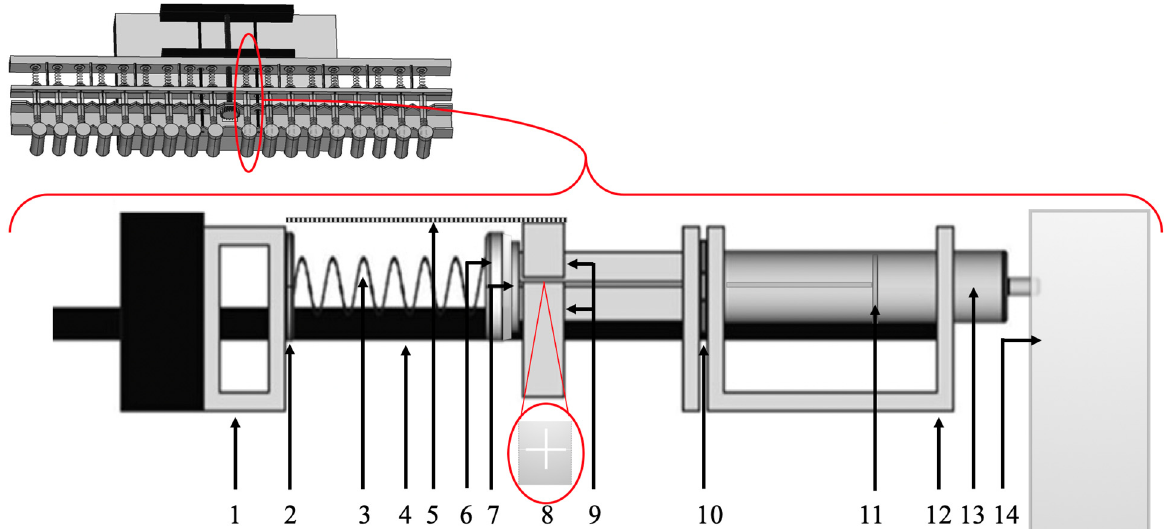
Figure 3. ( a ) Schematic top view on the in vitro model (top). ( b ): Cross section of the in vitro model with one unit displayed (below). (1—movement transmission bar; 2—disk; 3—spring; 4—spindle; 5—scale; 6—connector; 7—plunger endcaps; 8—recesses for syringe plungers; 9—retainer bar; 10—holder bars; 11—syringe plunger; 12—U-rail; 13—cavity of the syringe cylinder; 14—media reser-voir).